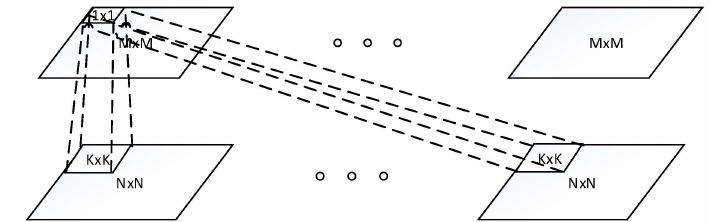
Figure 1. Architecture of one convolutional layer.